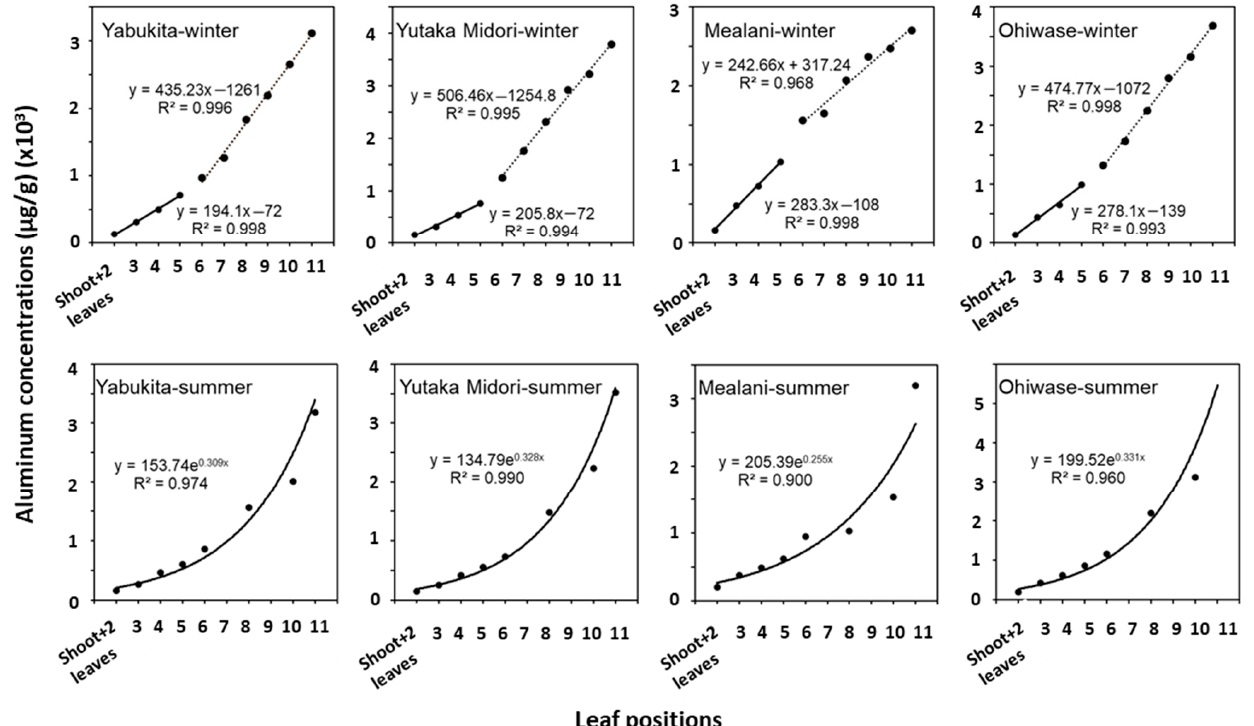
Figure 1. Relationship between the leaf positions and the mean concentrations of Al. Leaf positions